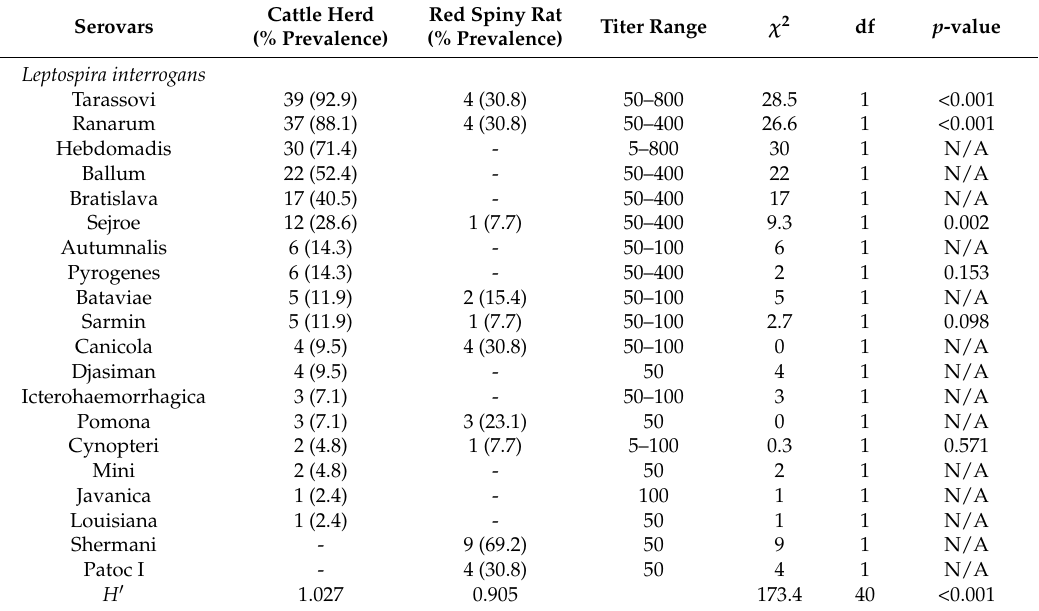
Table 2. Seroprevalence and the Shannon–Wiener diversity index of twenty Leptospira interrogans serovars found in domestic cattle herds (n = 42 herds) and red spiny rats (n = 70 sites) in Salakphra Wildlife